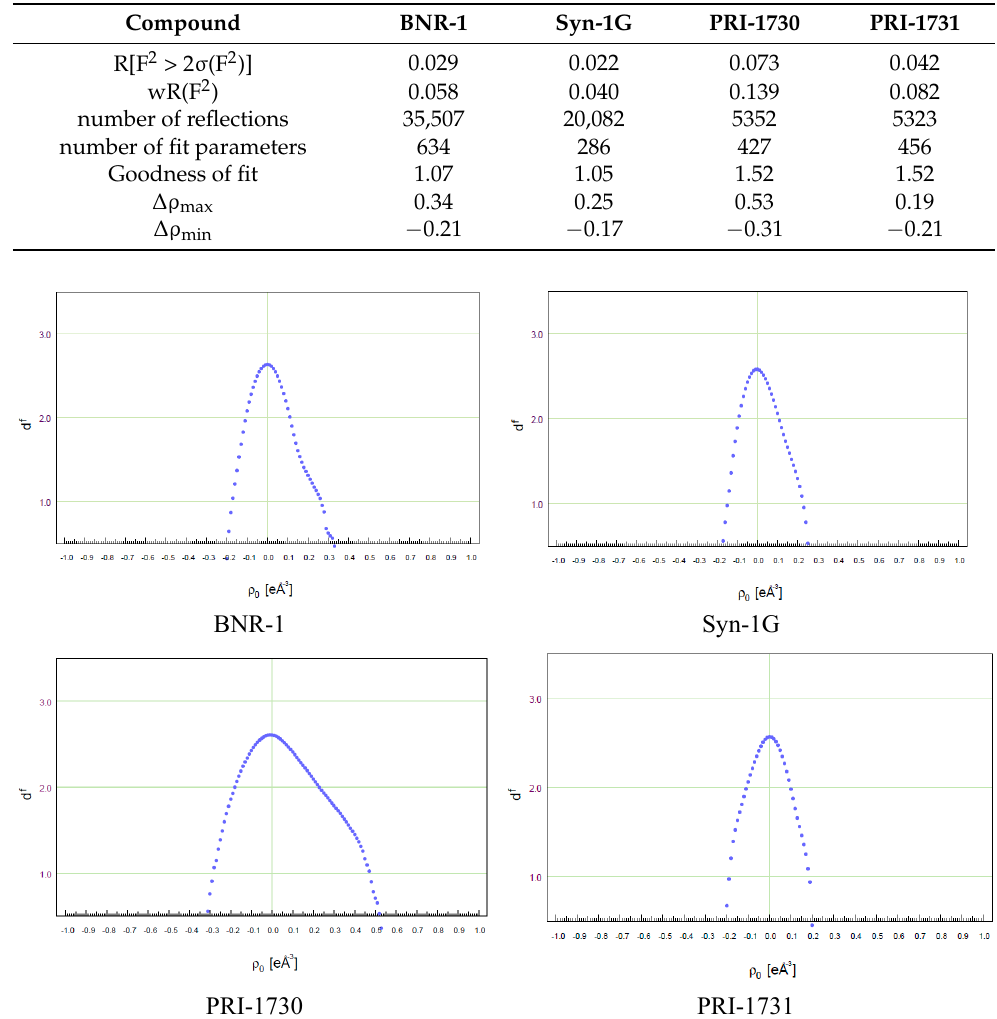
Figure 3. Fractal plots for BNR-1, Syn-1G, PRI-1730, PRI-1731.